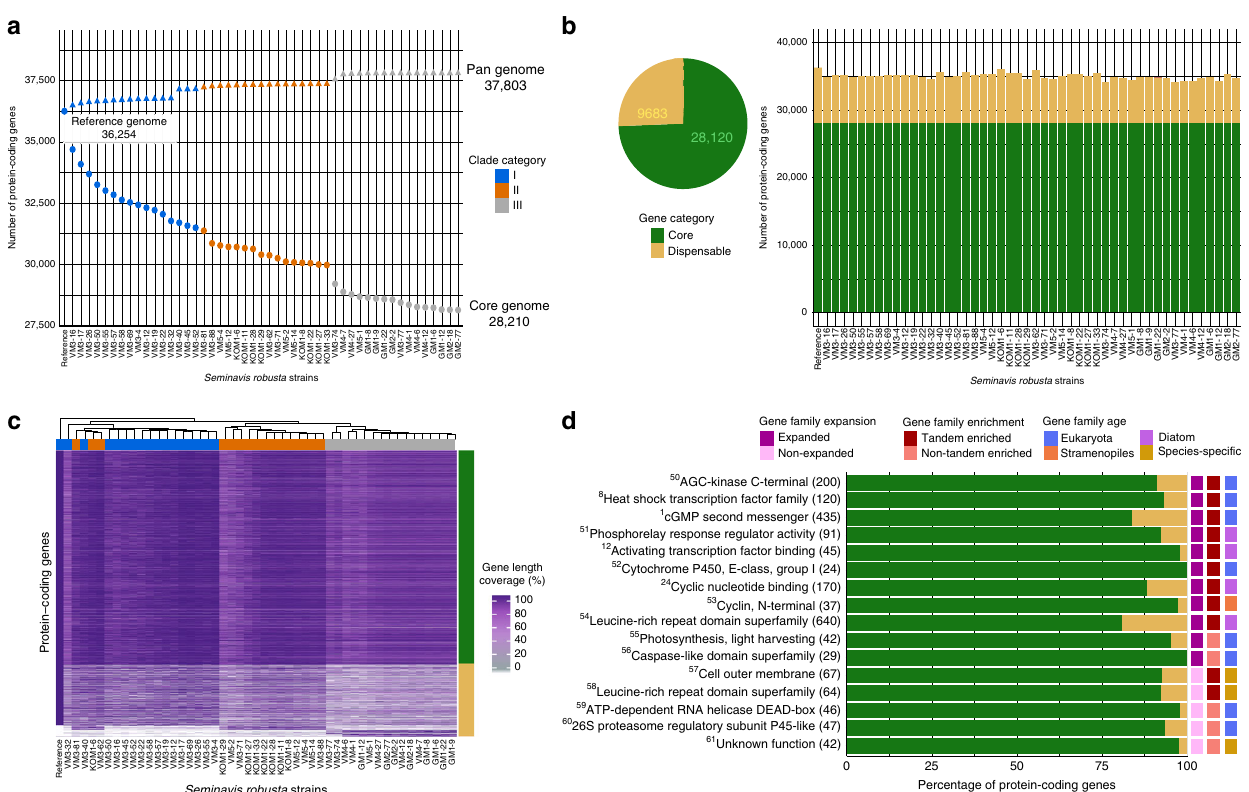
Fig. 4 S. robusta within-species variability using a gene-based pan-genome analysis. a Representation of reference, core and pan gene size. The size of pan genome increases with each added strain up to 37,803 protein-coding genes, whereas the size of core genome diminishes to 28,120 protein-coding genes. Clade category color code refers to the population groups described in ref. 14 . b Number of core and dispensable genes per S. robusta strain. The pie chart shows the total gene count, where core genes are genes present in all strains, dispensable genes are genes present in a subset of strains. c Percentage of gene length coverage by short read for all pan genes for each strain. The x axis represents the S. robusta strains, whereas the y axis represents all protein-coding pan genes. The percentage of horizontal gene coverage is highlighted by a color gradient from white (0%) to dark purple (100%). Gene categories are labeled on the right side of the y axis following the color code of panel b , whereas clade categories are labeled on the upper part of x axis following the color code of panel a . d Set of gene families that are signi fi cantly enriched in core genes. The x axis represents the percentage of protein-coding pan genes that are core or dispensable, following the color code of panel b , while the y axis represents gene families, denoting in parenthesis the total number of pan genes belonging to that gene family (reference and de novo genes). Expansion, tandem enrichment, and age of each family are highlighted in different colors on the right side of the y axis. Numbers in superscript refer to families annotated in Source Data fi le from Fig. 3. Source data underlying Fig. 4a, b are provided as a Source Data fi